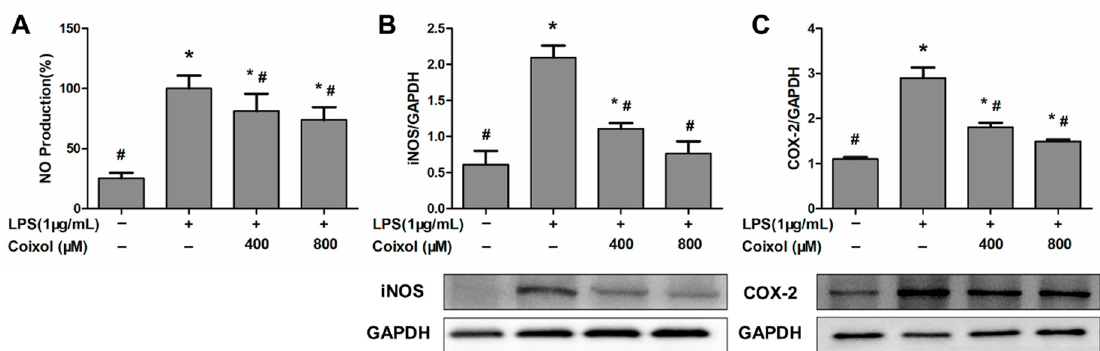
Figure 3. E ff ects of coixol on the expression of proinflammatory mediators in LPS-induced RAW 264.7 cells. Cells were pretreated with coixol for 4 h and then stimulated with 1 µ g / mL LPS for 4 h. ( A ) The production of nitric oxide (NO) in cells supernatant. NO was measured by Griess assay. The protein levels of ( B ) inducible-nitric oxide synthase (iNOS) and ( C ) cyclooxygenase (COX)-2. Protein levels were measured by western blotting. GAPDH was used as internal control. The data represent the mean ± SD (NO, n = 6; iNOS, COX-2, n = 3). * p < 0.05 vs. control group. # p < 0.05 vs. LPS group.